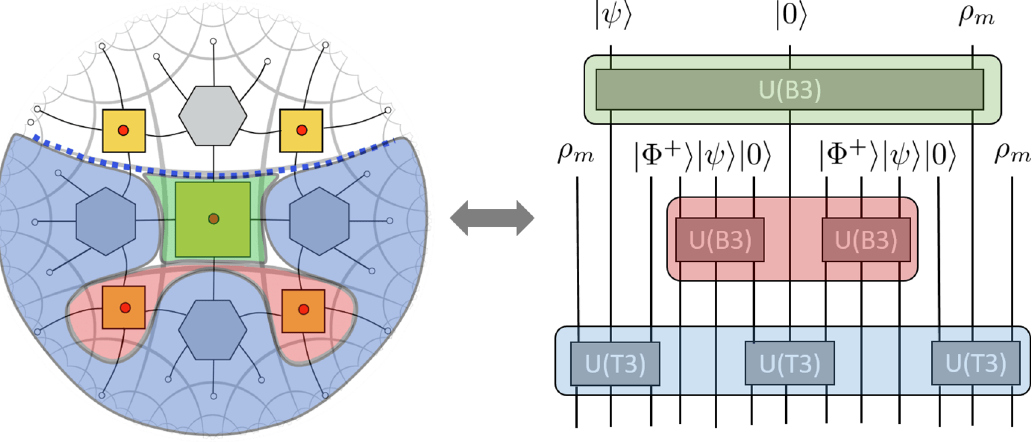
Figure 30. Decoding circuit for the bottom subsystem A below the dotted curve. ρ m are maximally mixed states and | ψ i denote logical information. They need not be the same information. Time runs up during decoding and down during encoding.